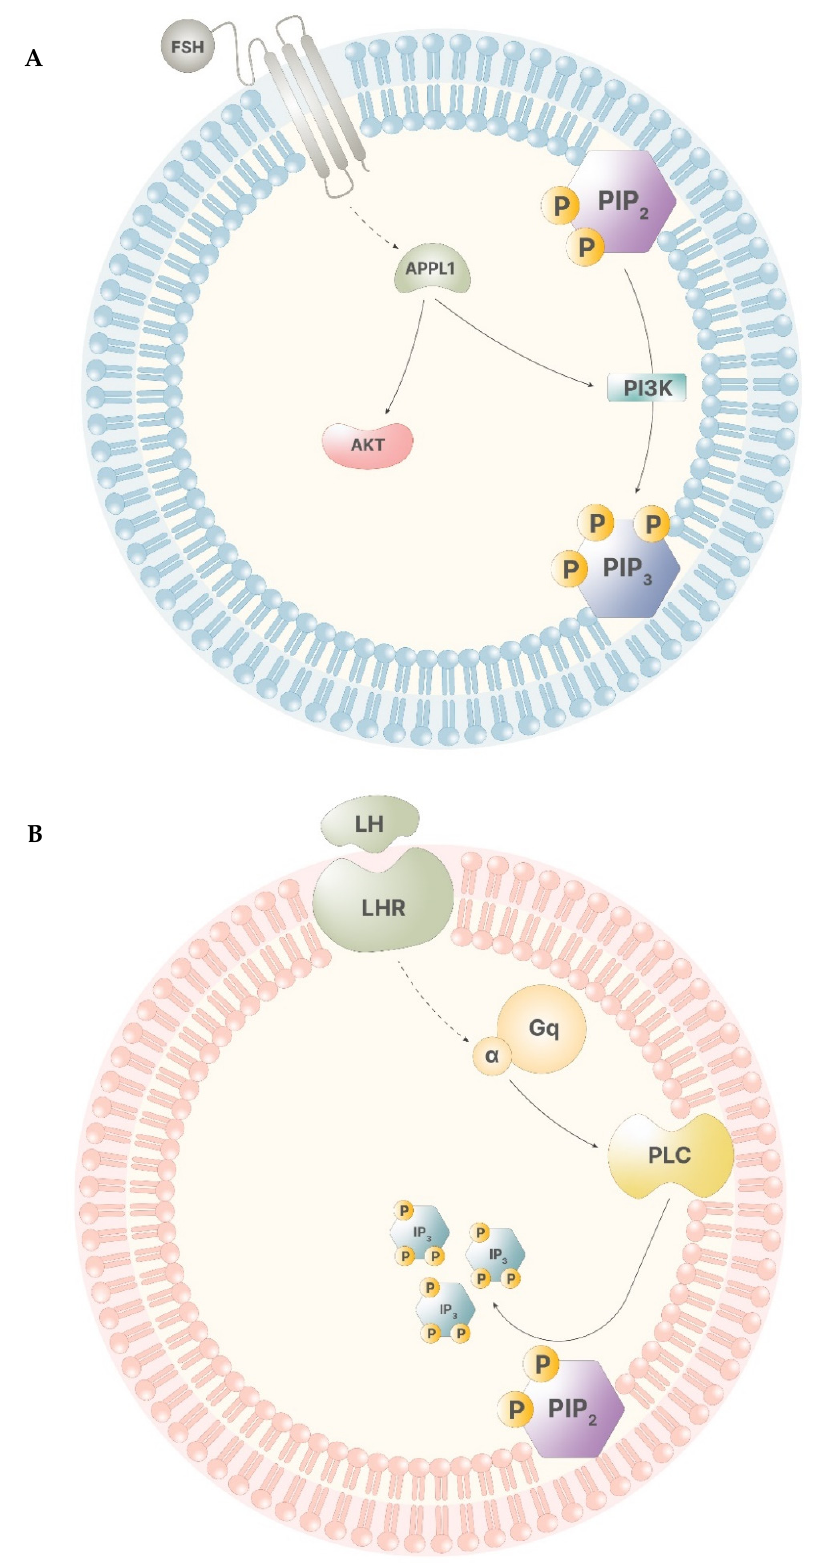
Figure 3. ( A )—The receptor of FSH has low affinity for APPL1, therefore, only high levels of FSH trigger APPL1 activation. APPL1 activates Akt and stimulates PI3K, leading to the production of PIP3. ( B )—The LH receptor poorly stimulates the activity of the alpha subunit of the Gq proteins. Thus, high LH levels lead to the activation of PLC that catalyze the cleavage of PIP2, producing IP3.